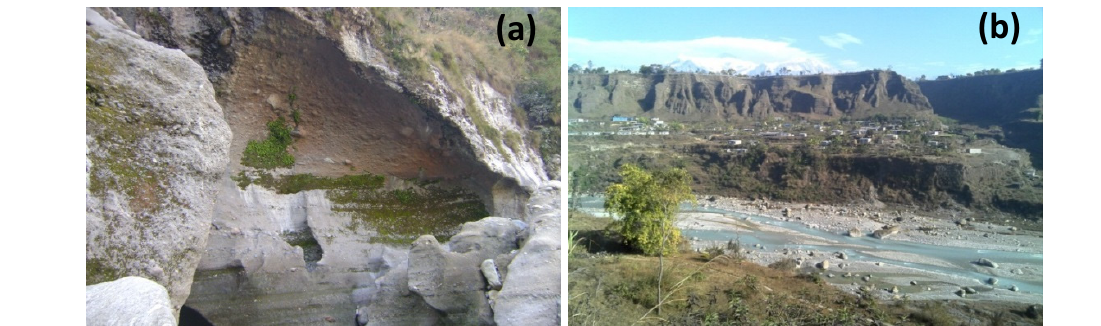
Figure 11. ( a ) Nadipur, 2014; ( b ) Dobilla (both sides),